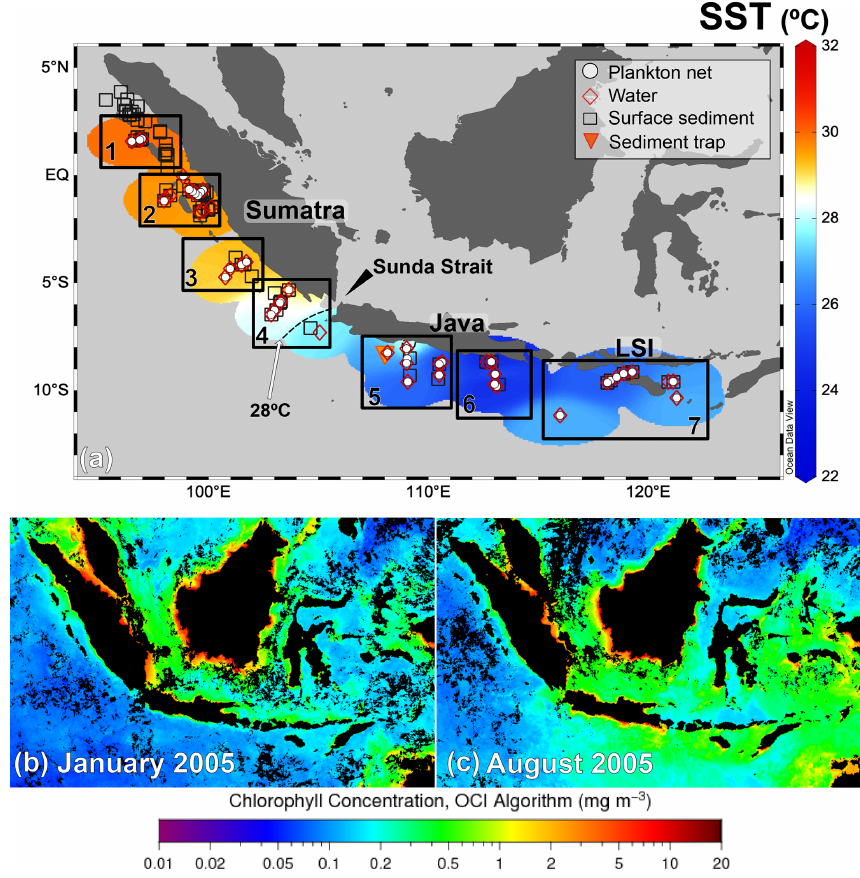
Figure 1. (a) Distribution of the in situ sea surface temperature in the study area during PABESIA cruise on board R/V Sonne in August 2005 (Hebbeln and cruise participants, 2006). The study area was divided into seven land–sea transects (numbered rectangles). The stations are divided into plankton net (white circles) and water (red diamonds). The locations of the sediment trap (Mohtadi et al., 2009) and surface sediments (Mohtadi et al., 2007) are indicated by the triangle and squares, respectively. Upper-ocean chlorophyll a (chl a ) (retrieved from https://oceancolor.gsfc.nasa.gov, last access: 8 November 2021) during (b) January (non-monsoon) and (c) August (SE monsoon) 2005, i.e., the sampling period. Temperature map was created with the Ocean Data View 5.2.1 (Schlitzer,